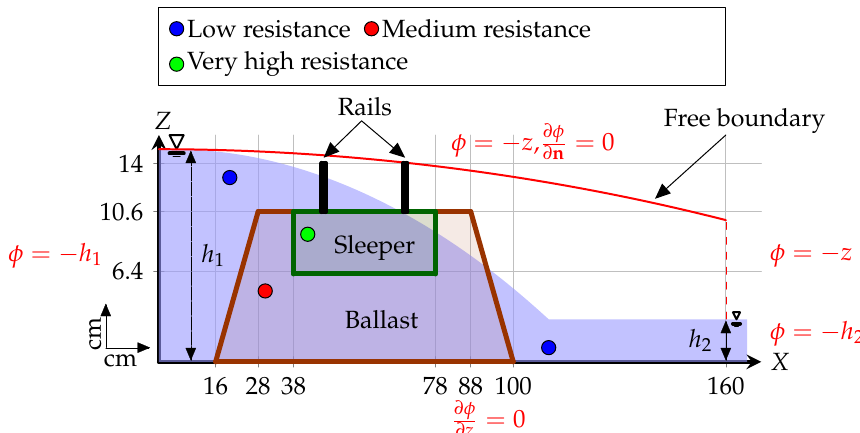
Figure 4. Schematic diagram of the experiment in [10]. The boundaries conditions of the hydraulic head φ are for this study. The position of the free boundary is the initial guess above the final water